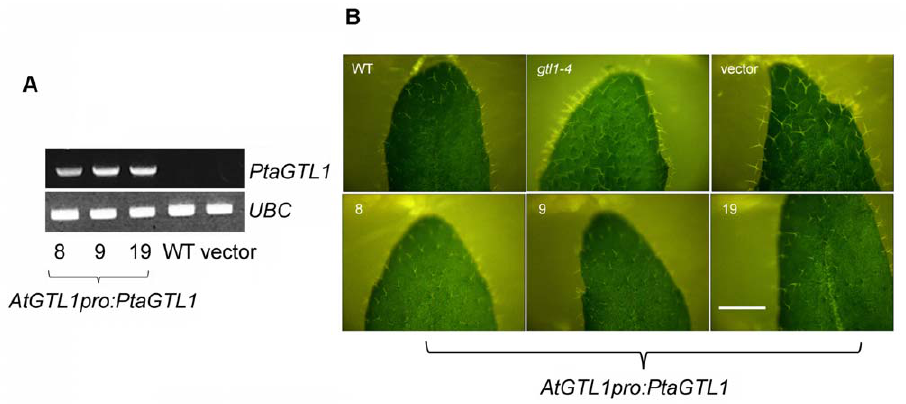
Figure 2. AtGTL1pro:PtaGTL1 expression suppresses the leaf trichome phenotype of gtl1-4 . WT is Col-0; vector is a transgenic line expressing pCAMBIA1302 in gtl1-4 ; 8, 9, and 19 are three transgenic lines expressing AtGTL1pro:PtaGTL1 in gtl1-4 . A. PtaGTL1 transcript abundance in 4-week-old plants was detected by RT-PCR with PtaGTL1 gene-specific primers (PtaGTL1 F2 and PtaGTL1 R2). UBC (ubiquitin conjugating enzyme 21, At5g25760) was used as an internal standard. B. Bright-field images, taken under a dissecting microscope, illustrate trichomes on the adaxial surface of fully expanded rosette leaves of 4-week-old plants. Bar indicates 4 mm.